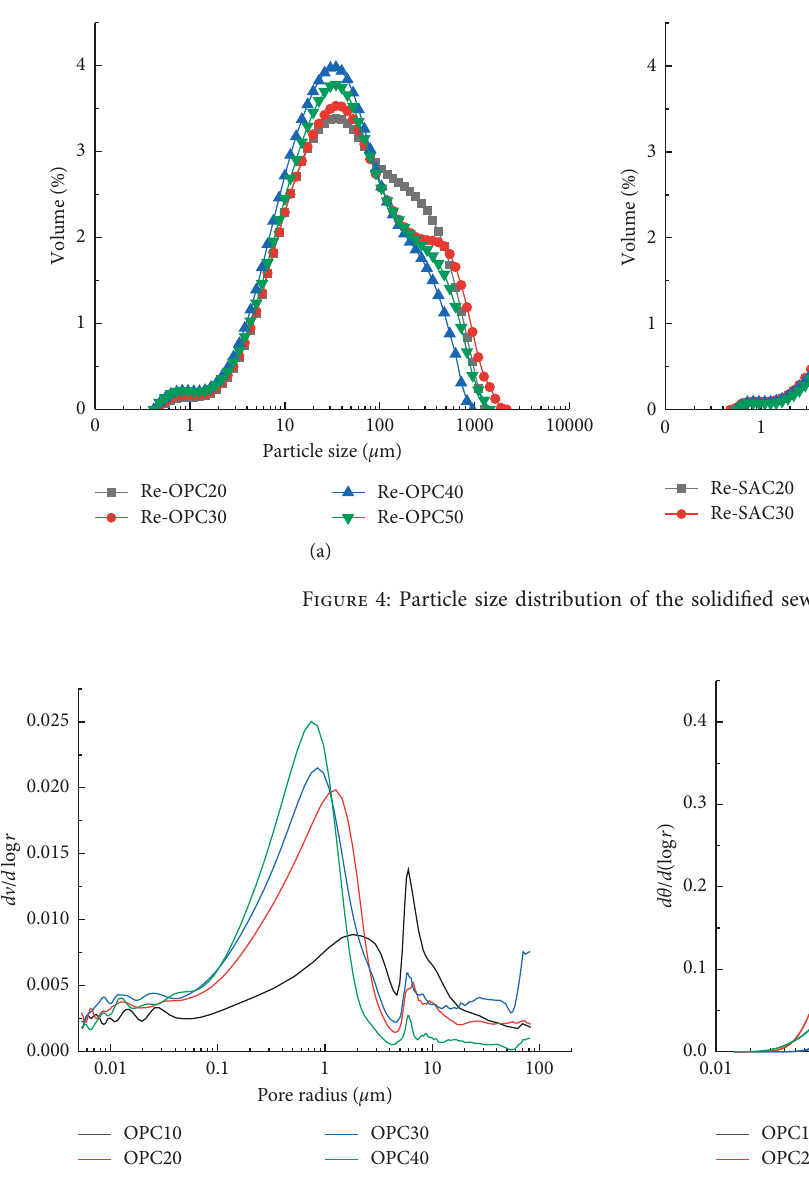
Figure 6: Effective pore size distribution of OPC-solidified sludge from centrifuge